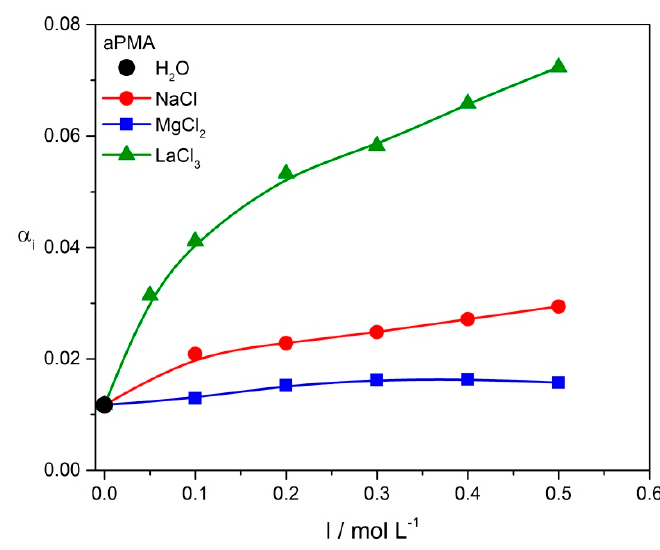
Figure 2. Calculated α i values for aPMA ( c m = 2 g · L − 1 , α N = 0) in dependence on I in aqueous NaCl, MgCl 2 and LaCl 3 solutions.